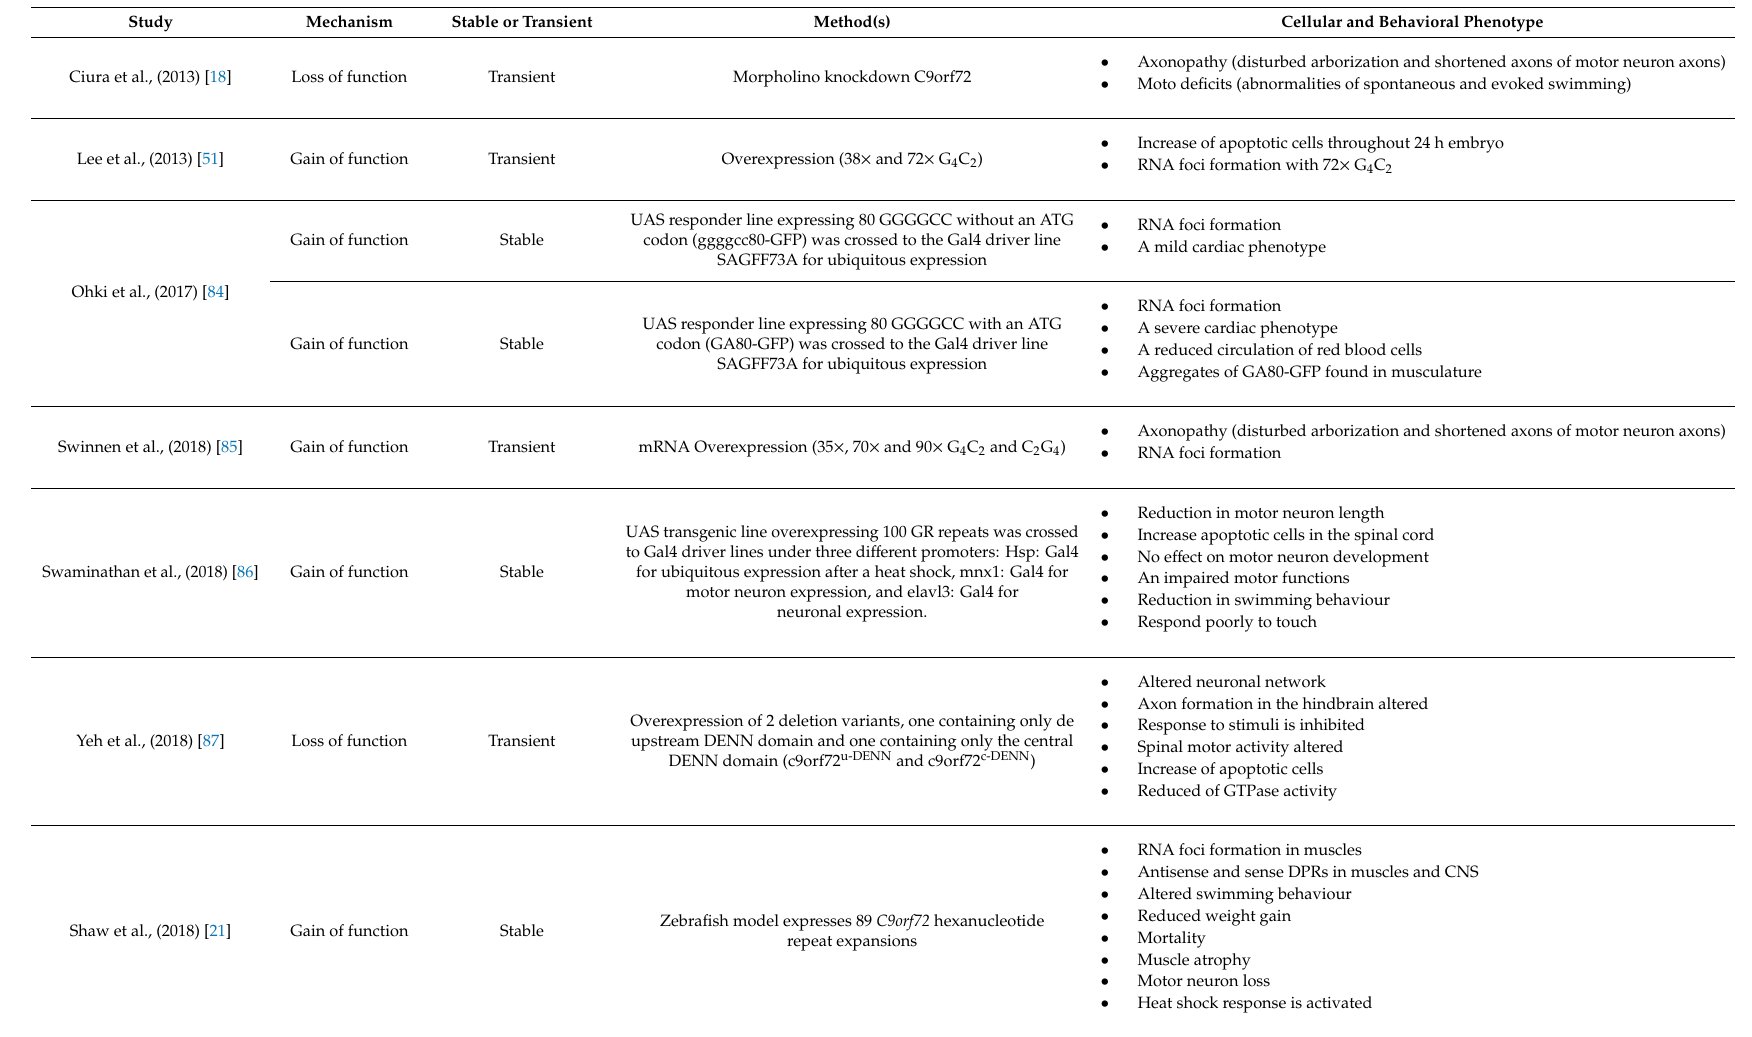
Table 1. Summary of the di ff erent zebrafish C9orf72 models and their distinct